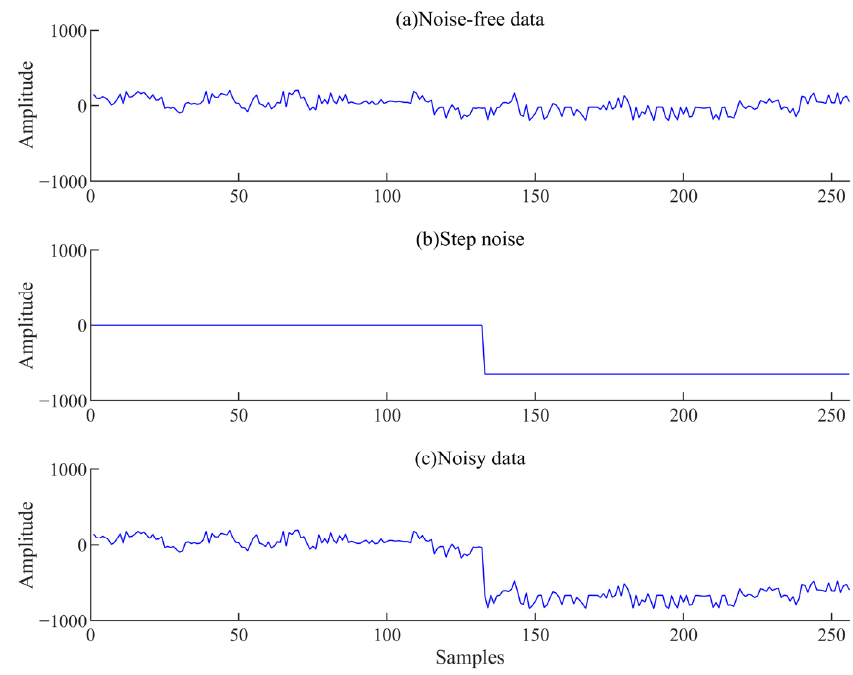
Figure 6. Synthesis of step noise. ( a ) Noise-free data, ( b ) step noise, ( c ) noisy data.